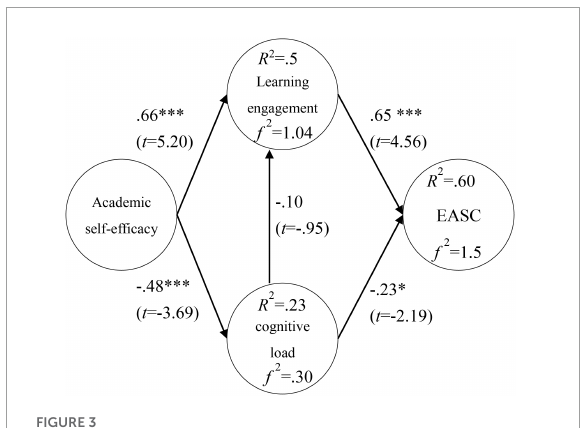
FIGURE3 Research model validation. * p < 0.5, *** p <